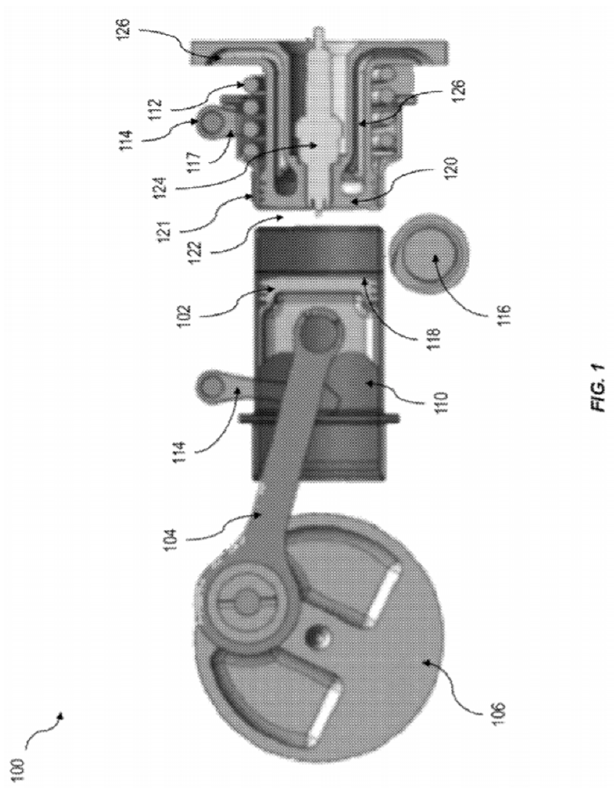
Figure 21. J. Cleeves 16 May 2017, Single piston sleeve valve with optional variable compression ratio capability US 9650951. Reproduced with permission from US Patent Office Copyright Publisher,